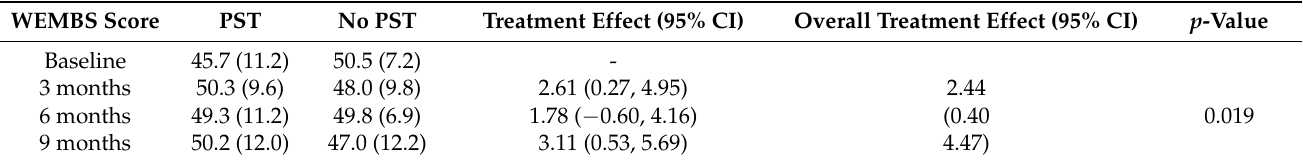
Table 2. Table showing mean (SD) Rasch-transformed WEMWBS scores at each time-point broken down by treatment group, with the overall treatment effect. The estimated treatment effects